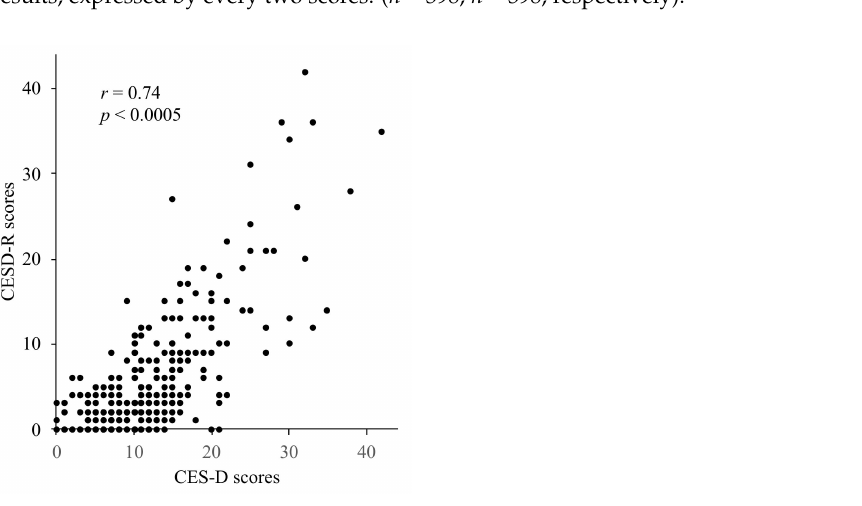
Figure 1. Distributions of CES-D and CESD-R results displayed as histograms of CES-D and CESD-R results, expressed by every two scores. ( n = 398, n = 398, respectively).